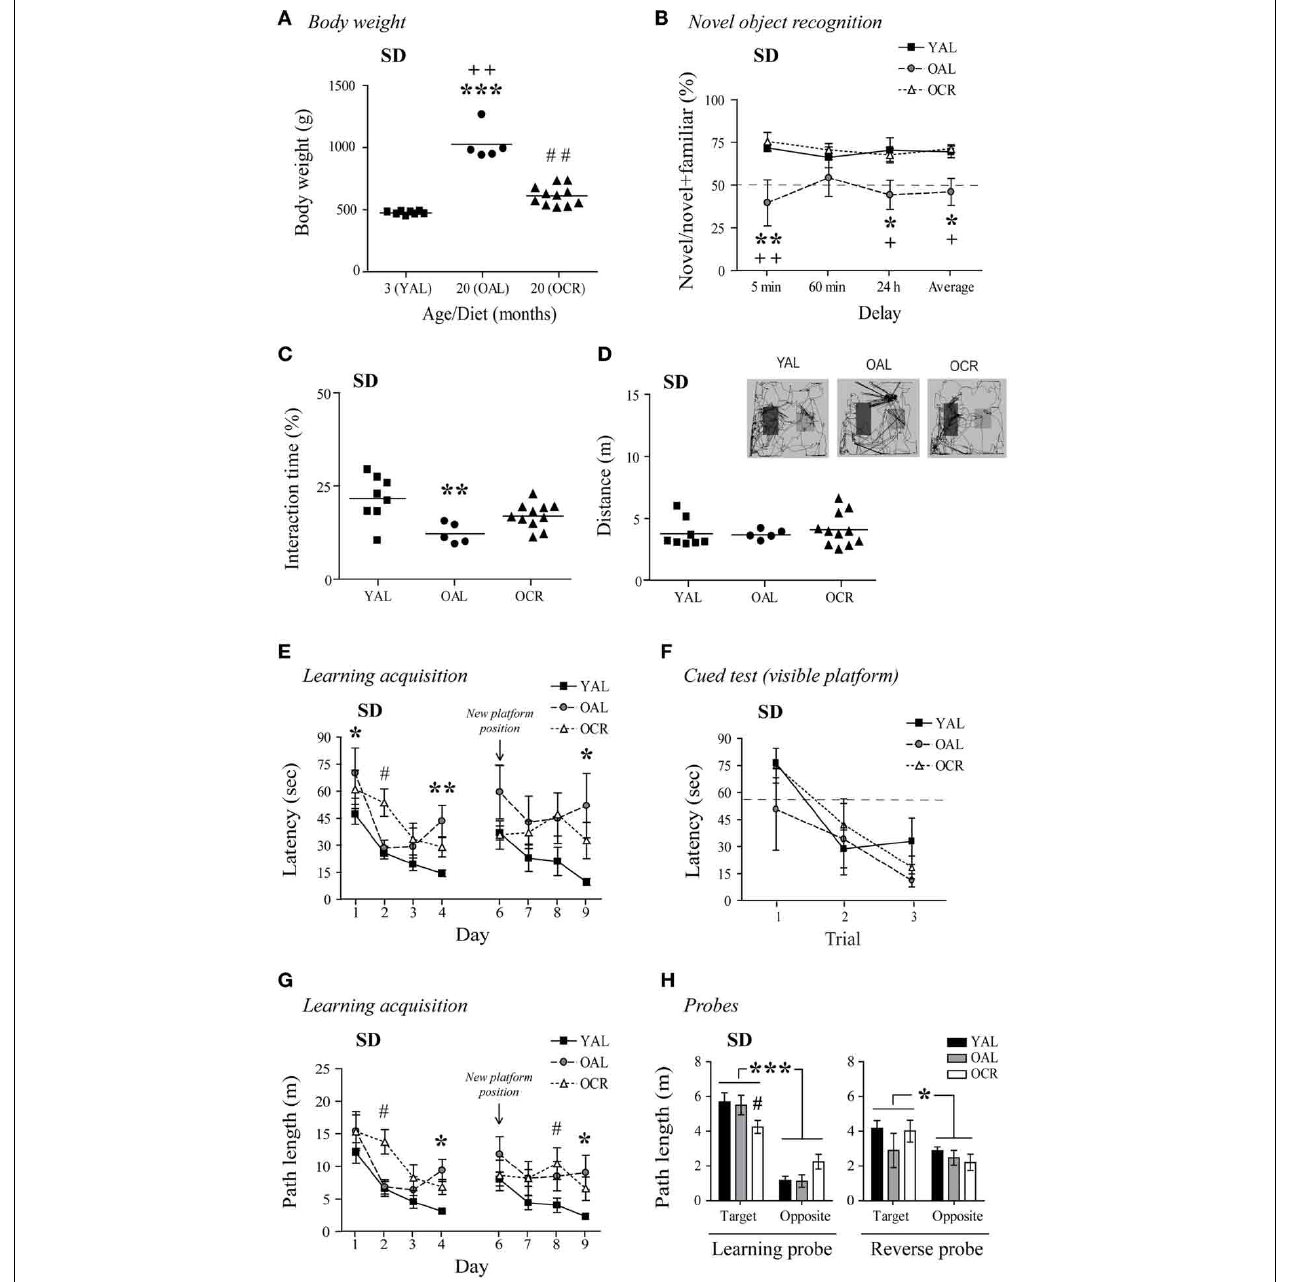
FIGURE 3 | Long-term caloric restriction prevents age-related body weight increase and minimizes the cognitive deficits observed in old AL male SD rats. (A) The age-related increase in BW is prevented by LTCR in SD rats (YAL, young ad-libitum -fed; OAL, old ad-libitum -fed; OCR, old calorie-restricted). (B) OAL SD rats spent less time interacting with novel objects on average and after a 5-min or 24-h delay compared to YAL and OCR rats. (C) OAL SD rats spent less time interacting with the objects during the test compared to YAL rats. (D) Distance traveled in the arena was not different between SD age groups. Representative paths (60min delay) are shown with novel object on the right side. (E) MWM learning acquisition curves of the YAL, OAL, and OCR SD rats (three trials per day). Performances were significantly different when compared to YAL for OAL on day 1, 4, and 9, and OCR on day 2. These differences were not related to visual deficits, motor function, or lack of motivation to escape water as assessed by the cued test (F) . (G) Longer